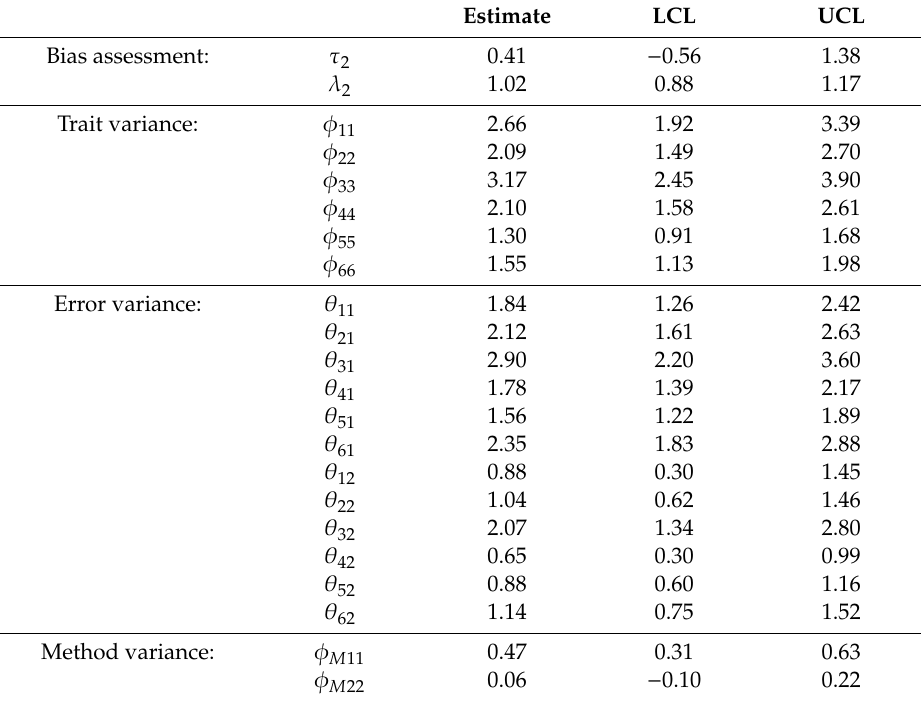
Table 2. Model parameter 1 estimates and 95% confidence interval limits. (lower limit, LCL; and upper limit, UCL).